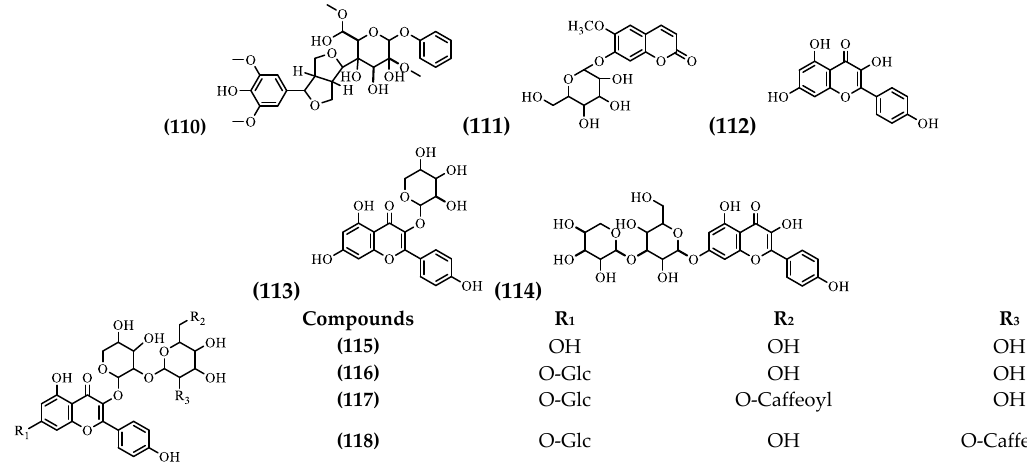
Figure 5. Structure of Phenolic Compounds, Coumarin, and Flavonoids from Brugmansia suaveolens.